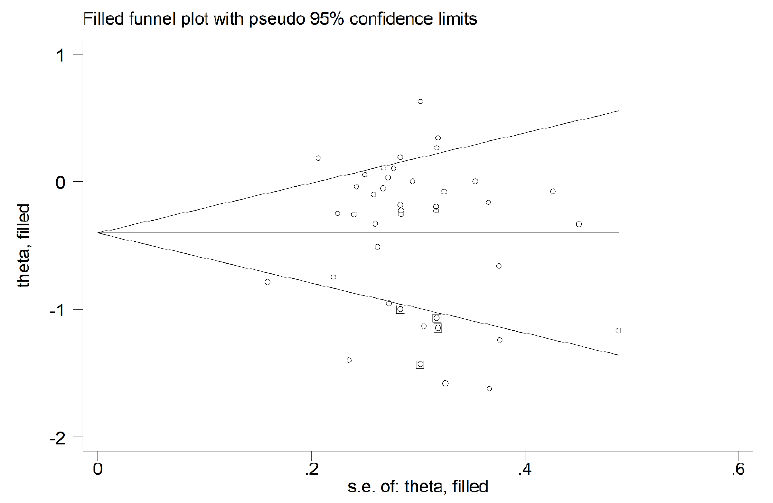
Figure 13. Funnel plot of studies investigating E-Selectin concentrations before and after statin treatment after “trimming-and-filling”. Dummy studies and genuine studies are represented by enclosed circles and free circles, respectively.